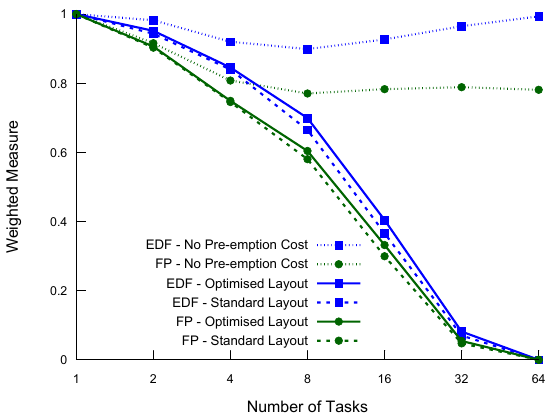
Figure 12 Weighted measure for varying the number of tasks from 2 0 to 2 6 while maintaining a constant ratio of number of tasks to cache utilisation.